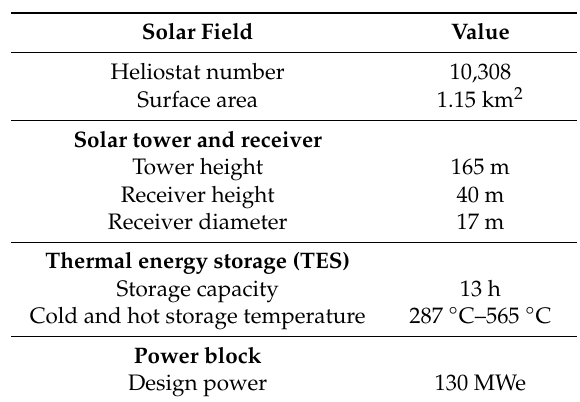
Figure 3. Schematic of a concentrated solar power (CSP) tower system. Table 1. Input design parameters for CSP tower plant